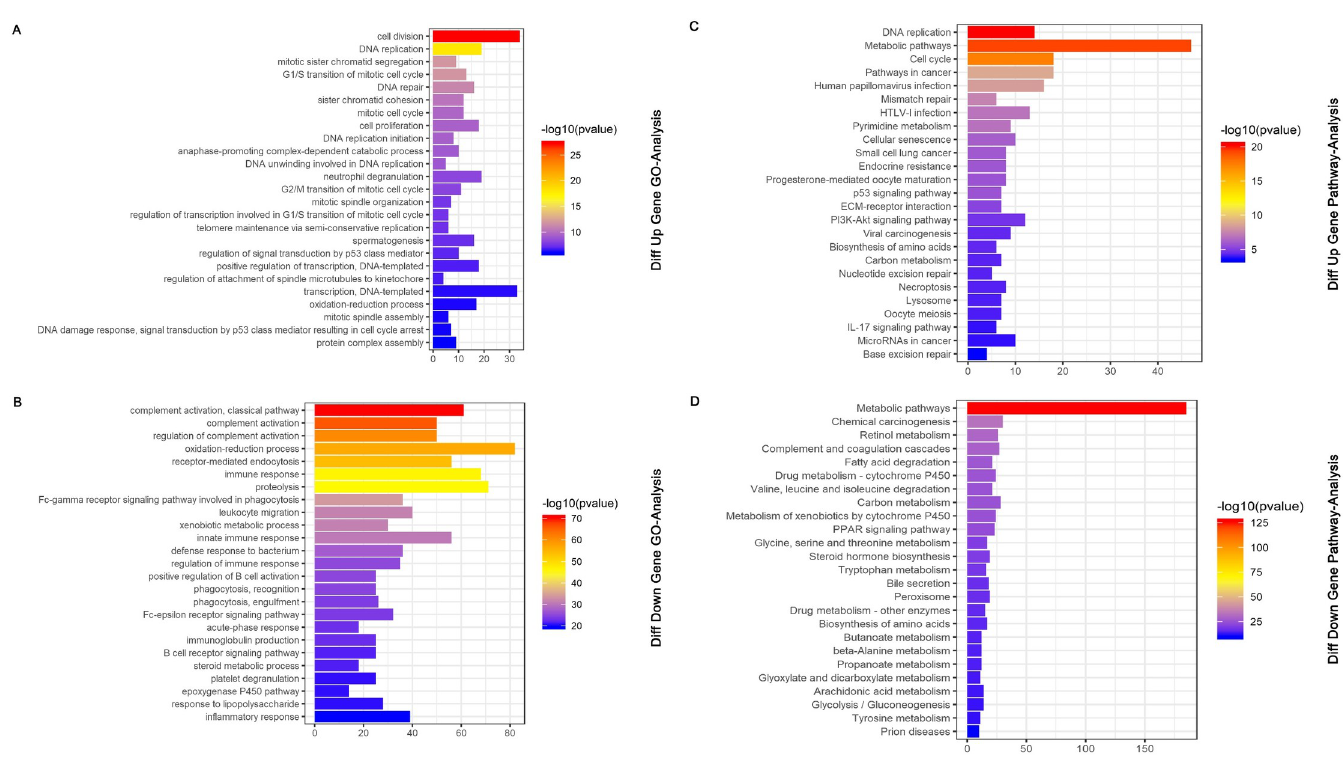
Fig 3. Functional enrichment analysis of the differentially expressed mRNAs. (A) Top 25 GO analyses of upregulated DEmRNAs. (B) Top 25 GO analyses of downregulated DEmRNAs. (C) Top 25 GO KEGG pathways of upregulated DEmRNAs. (D) Top 25 GO KEGG pathways of downregulated DEmRNAs.